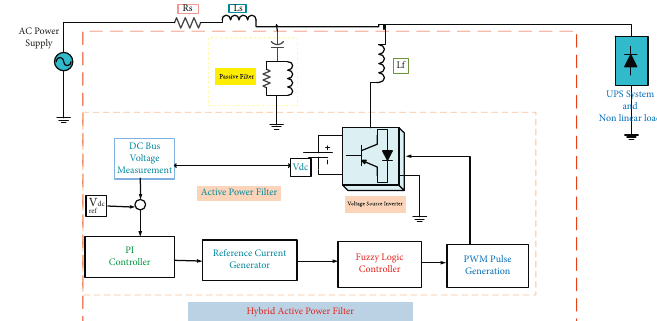
Figure 14: Proposed FLCC for single-phase half-bridge HAPF.